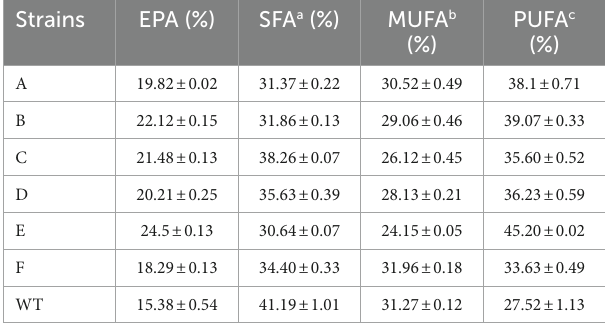
TABLE 1 Fatty acid composition of the WT and